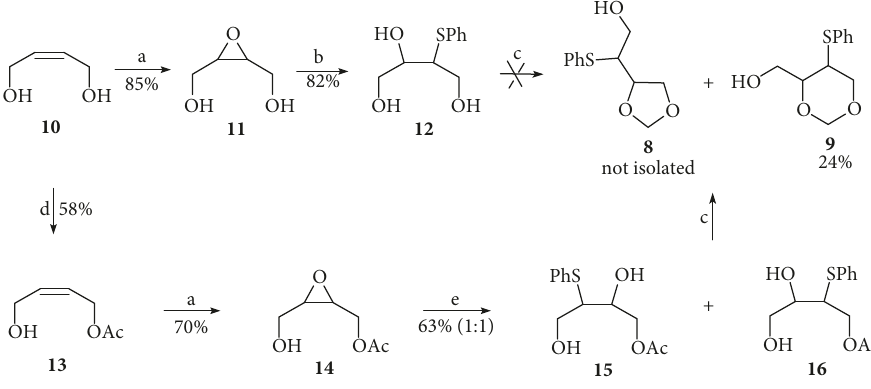
Scheme 2: Synthesis of hydroxysulfides of 1,3-dioxane and 1,3-dioxolane